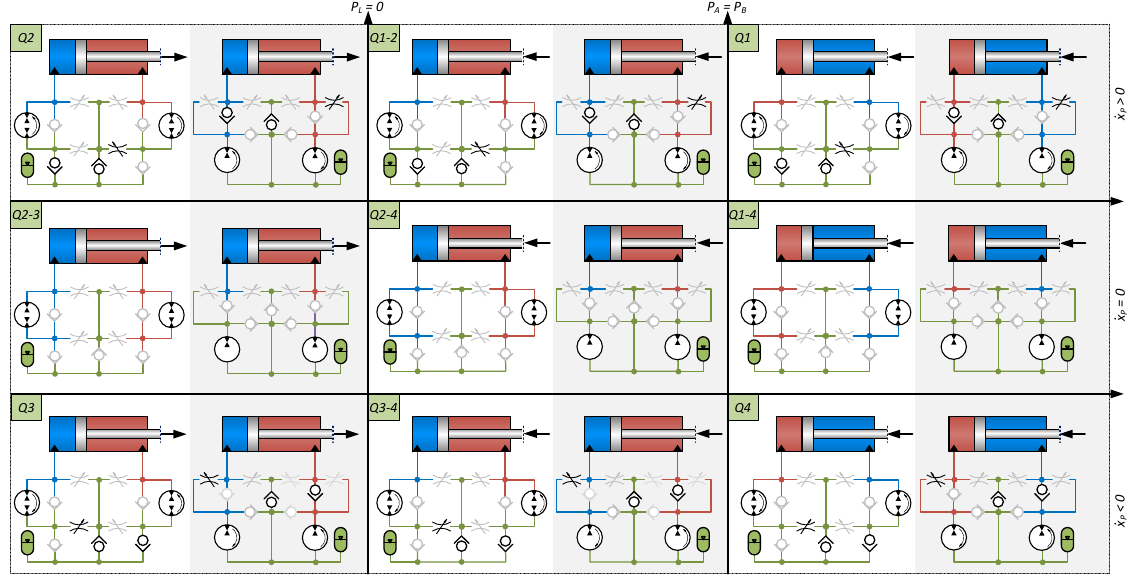
Figure 5. Operations schematics for drive architectures of Figure 3, when only actuating the auxiliary valves. Schematics in shaded areas are representative for architectures DPDS-R and SPDS-R, whereas the schematics in non-shaded areas are representative for architectures